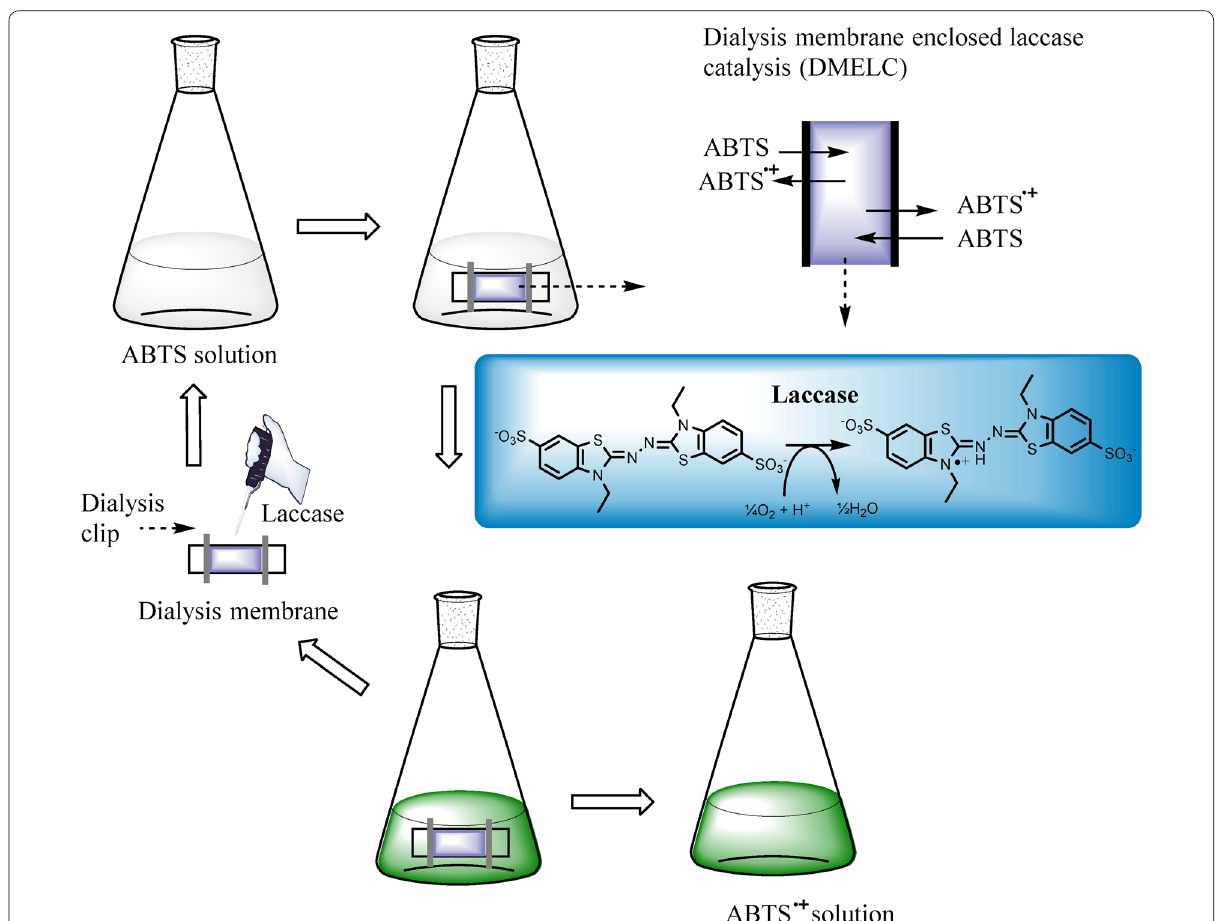
Fig. 1 The schematic diagram of enzyme recycling using DMELC for ABTS